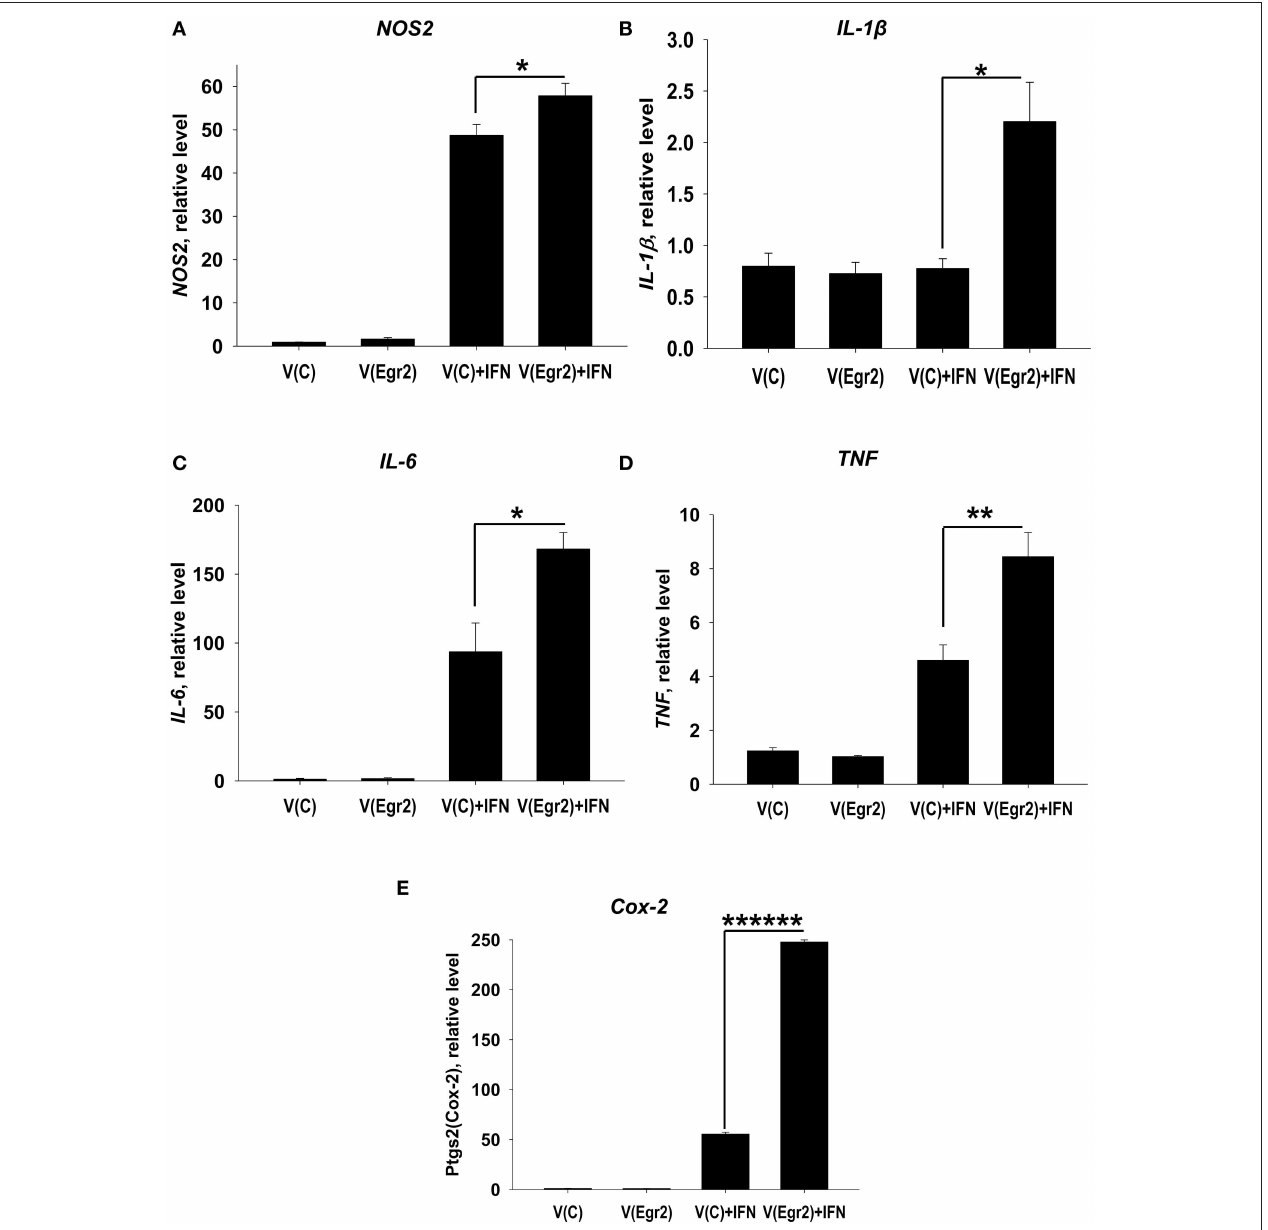
FIGURE 9 | Analysis of expression of M1-associated markers (NOS2, IL-1 β , IL-6, TNF, Cox-2) in IFN γ -activated macrophage cell line with overexpression of Egr2. Macrophage cell line RAW264.7 was transfected with empty (control) pMIG expression vector plasmid [V(C)] or vector with Egr2 [V(Egr2)] for 24h as described in Materials and Methods . Then the cells were used as unstimulated [V(C) and V(Egr2)] or activated with IFN γ (100ng/ml) for another 24 h-time period [V(C) + IFN and V(Egr2) + IFN]. The cells were washed, mRNA was isolated, and the expressions of NOS2 (A) , IL-1 β (B) , IL-6 (C) , TNF (D) , Cox-2 (E) were analyzed by real-time PCR as described in Materials and Methods . In (A–E) , mean ± S.E. of six separate culture plate wells is shown (* p < 0.05; ** p < 0.01; ****** p <